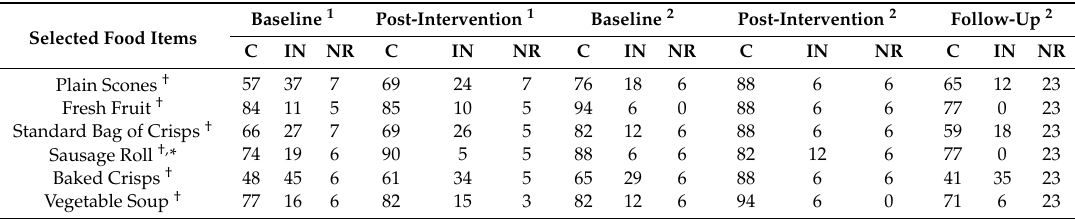
Table 5. Correct and incorrect responses to the fat content of common food products at baseline and post-intervention ( n = 62) and 3–4 month follow-up ( n = 17). Baseline 1 Post-Intervention Selected Food Items